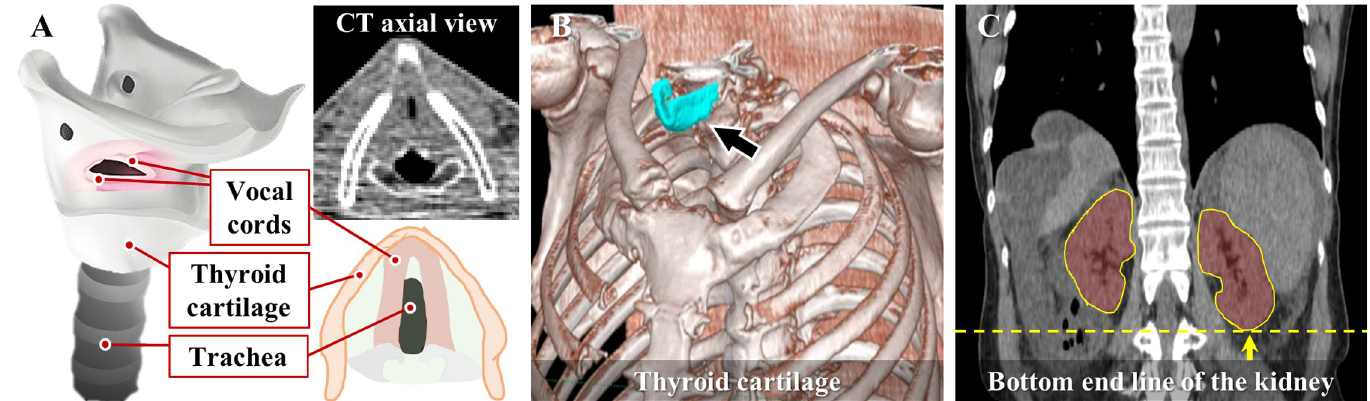
Fig 1. Representative landmarks in overscan decision. (A) Vocal cord as an initial superior-side landmark, (B) Thyroid cartilage as a replaced superior-side landmark, (C) Kidney as an inferior-side overscan landmark.